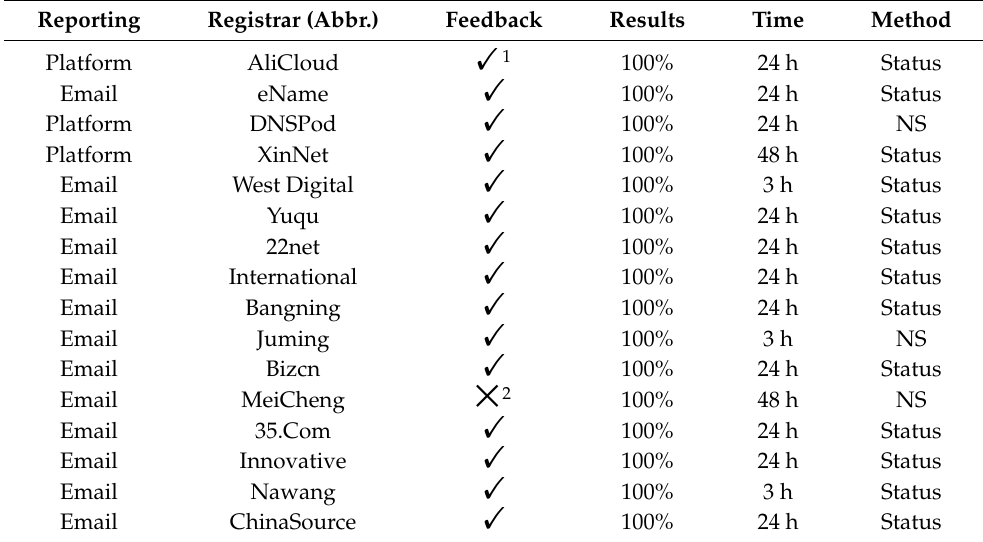
Table 4. Overview of domain registrars and handling results of abusive domain